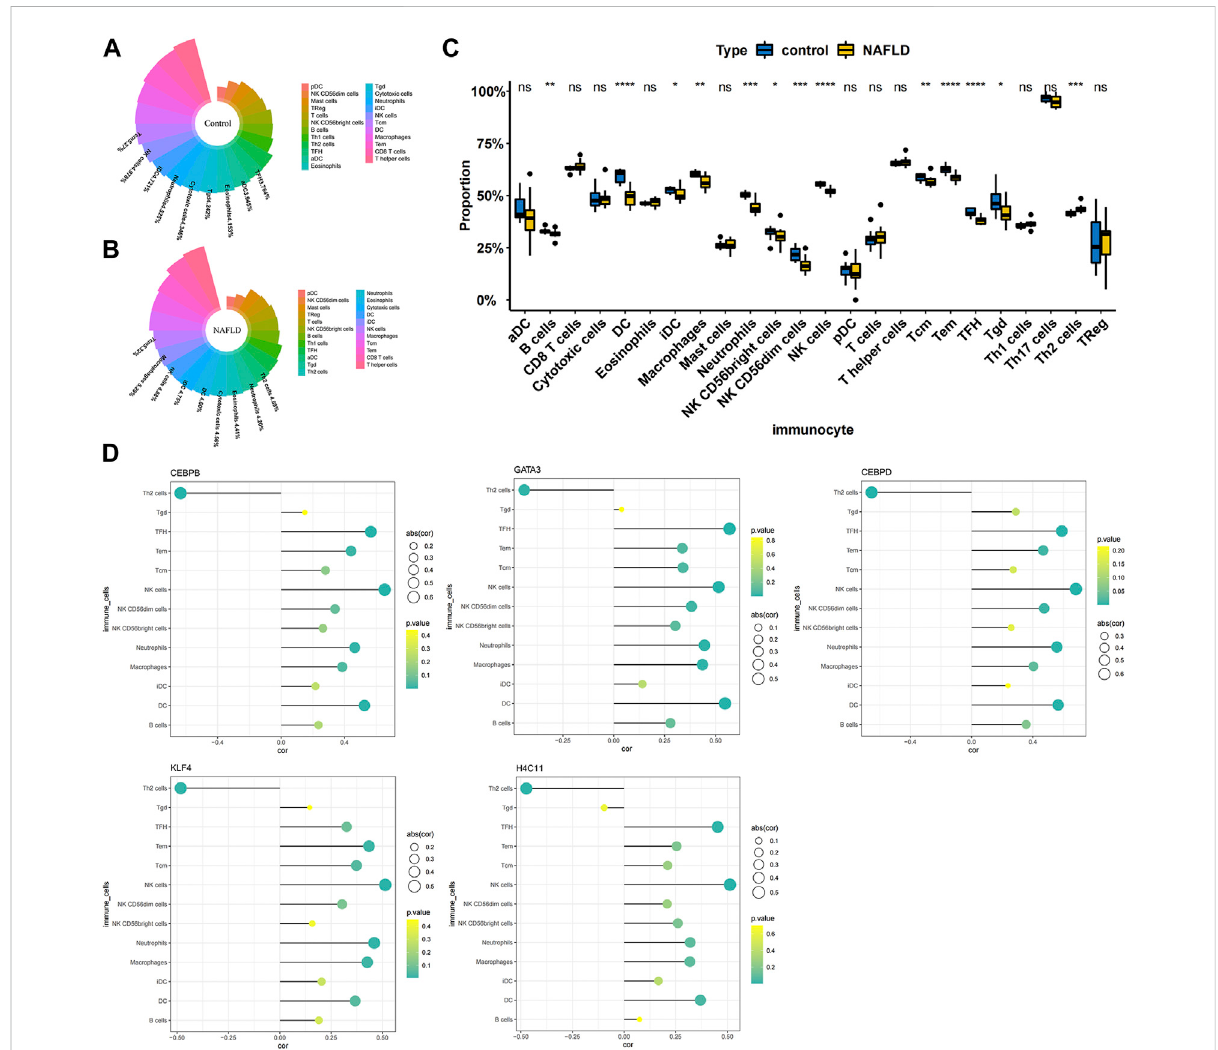
FIGURE 5 Correlation between diagnosticbiomarkersandimmune cellin fi ltration. (A) Nightingalerosediagramofimmunecellproportionsinthenormal group samples. (B) Nightingale rose diagram of immune cell proportions in the NAFLD group samples. Each colour indicates an immune cell; the larger the area per colour, the larger the proportion of cells. (C) Boxplot of the immune cell proportion. “ * ” p < 0.05, “ ** ” p < 0.01, “ *** ” p < 0.001, and “ **** ” p < 0.0001. (D) Lollipopchartofthecorrelationbetweendiagnosticbiomarkersandimmunecells.Thecirclesizeindicatesthecorrelation magnitude; the colour from green to yellow indicates an increased p-value